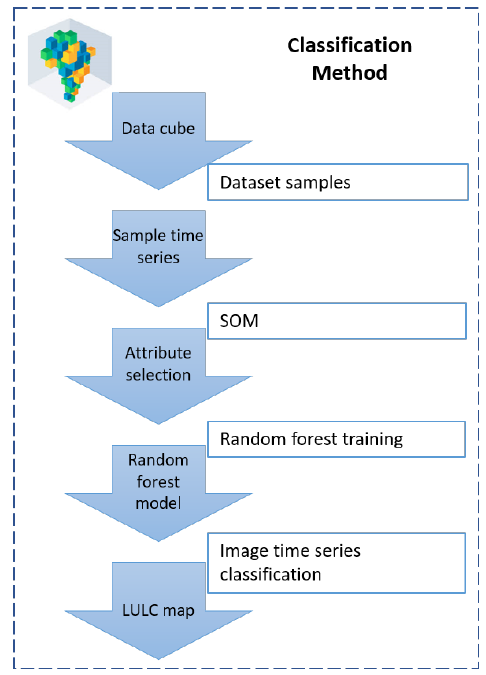
Figure 2. Land use and land cover classification